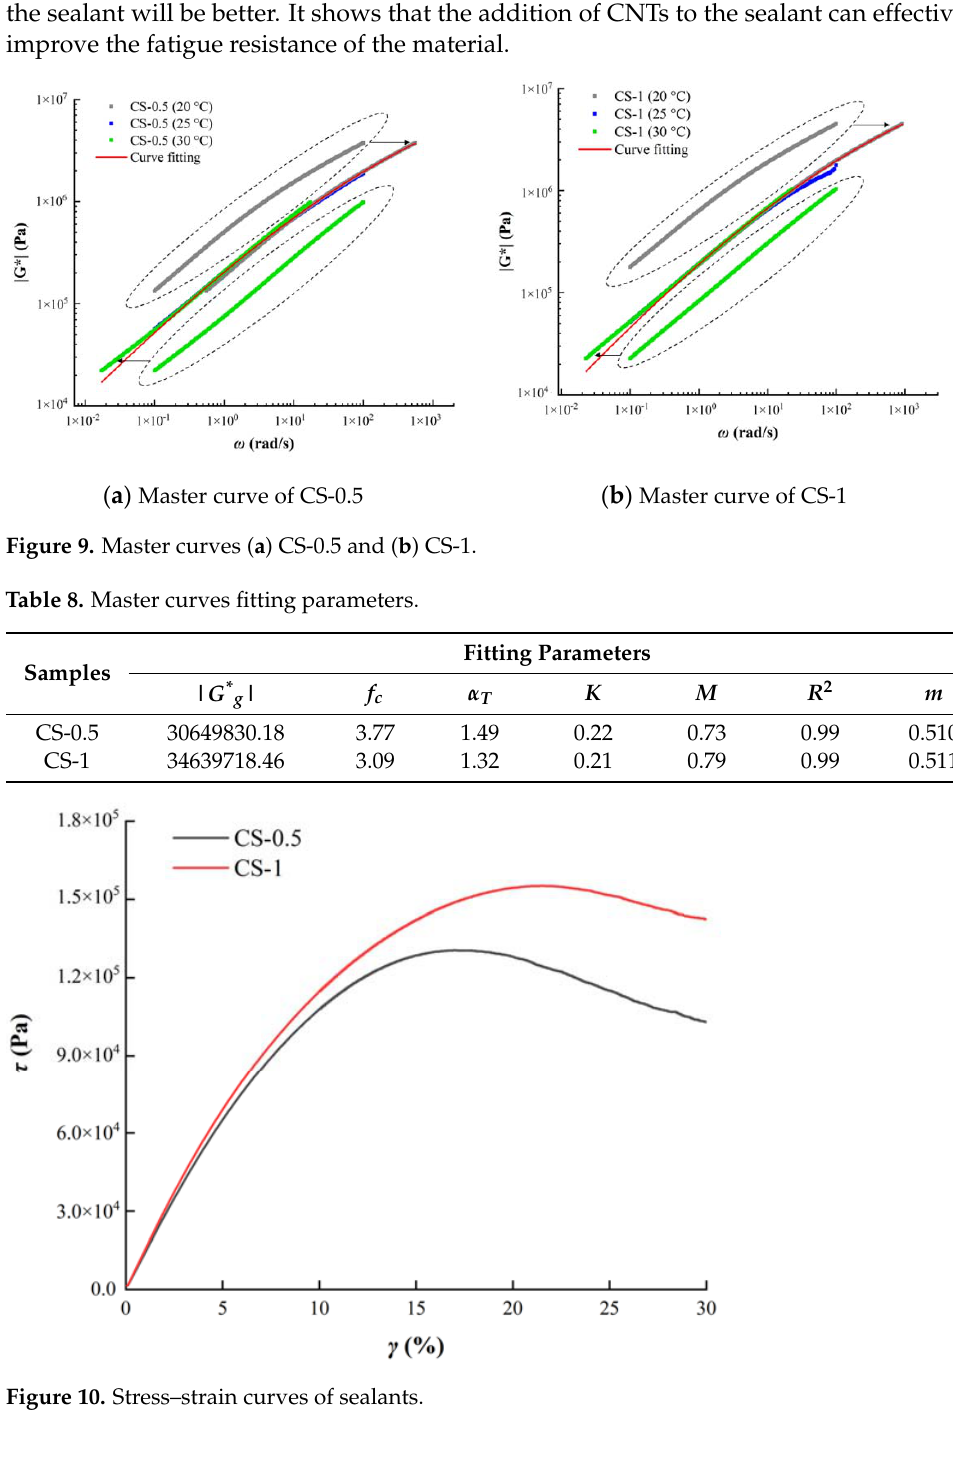
Figure 10. Stress–strain curves of sealants.